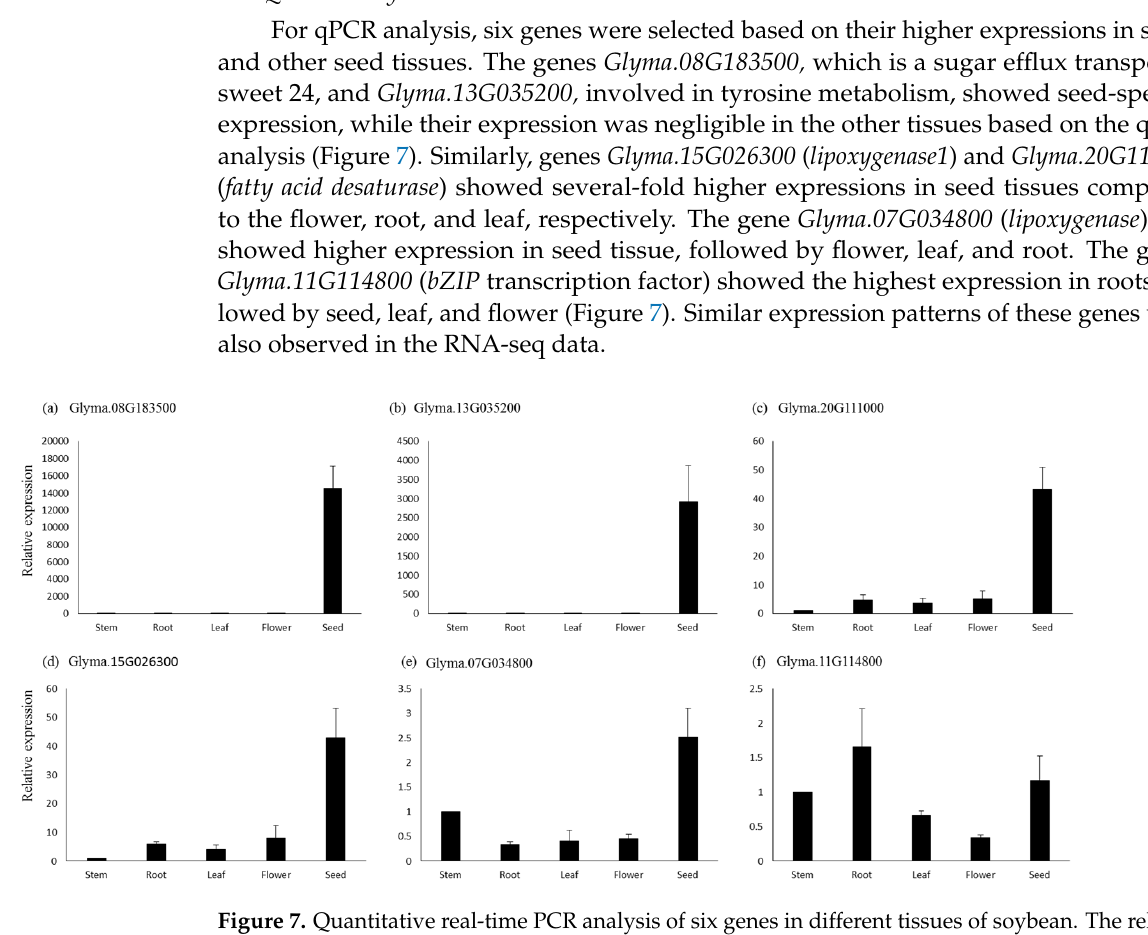
Figure 7. Quantitative real-time PCR analysis of six genes in different tissues of soybean. The relative expressions for all genes were calculated using 2 −∆∆CT. Bars represent the standard errors of the means of three biological and technical replicates.